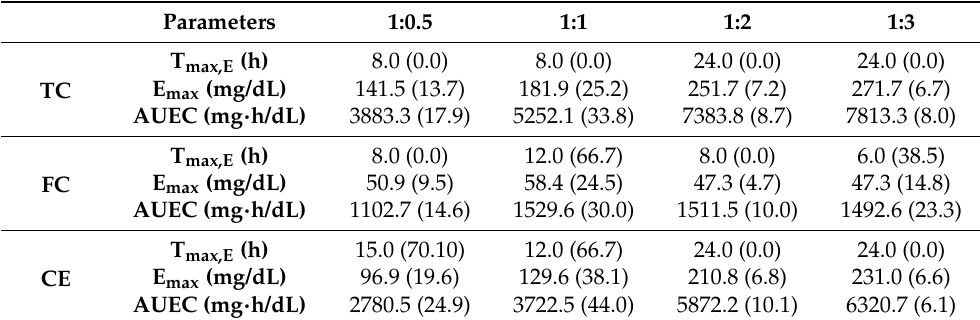
Figure 5. A pharmacokinetic/pharmacodynamic study was completed using Sprague Dawley Rats. Micelles were injected via tail vein injection and blood was collected from the jugular vein. The concentration of ( A ) phospholipid, ( B ) total cholesterol (TC), ( C ) free cholesterol (FC), and ( D ) cholesterol ester (CE), over a 48-h time frame were measured using commercially available kits. Profiles of concentration vs. time are displayed over a 48 h time period to examine the effect of DMPC:DSPE-PEG2k ratio on the phospholipid pharmacokinetics and cholesterol mobilization ability of the micelles ( n = 4, mean ± SD). Table 5. Pharmacodynamic parameters (% CV) of total cholesterol (TC), free cholesterol (FC) and cholesterol ester (CE) for DMPC micelles containing different ratios of PC:DSPE-PEG lipid dosed at 136 µ